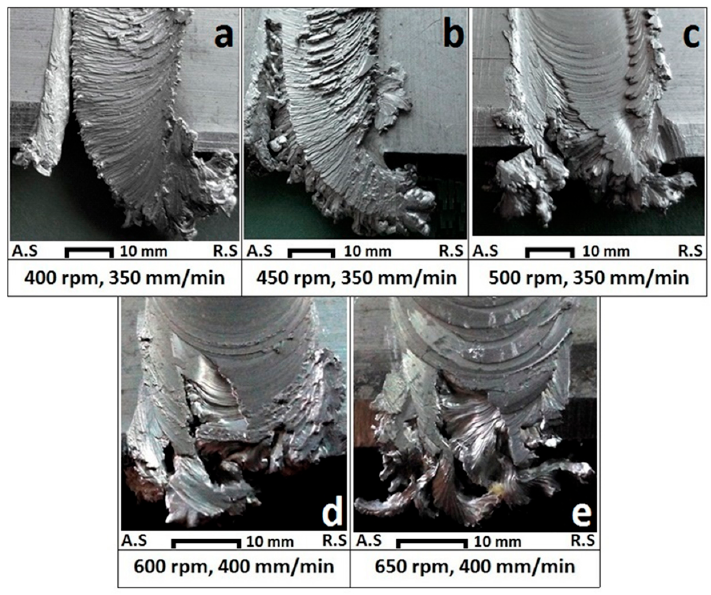
Figure 8. The entry region (Top view) in different ( ω / V ) ratios, ( a ) 400 rpm, 350 mm/min; ( b ) 450 rpm, 350 mm/min; ( c ) 500 rpm, 350 mm/min; ( d ) 600 rpm, 400 mm/min; and ( e ) 650 rpm, 400 mm/min.